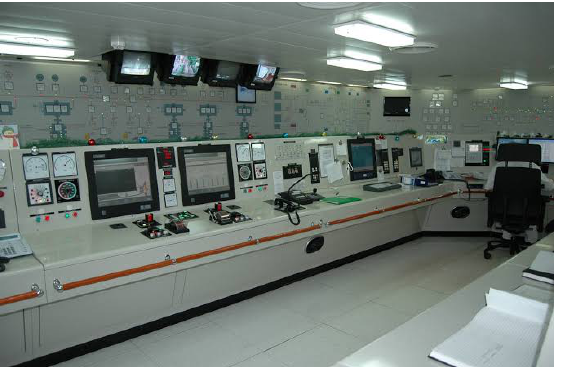
Figure 1. Control room example. Image owned by Michael Elleray and is under Creative Commons https://creativecommons.org/licenses/by/2.0/.